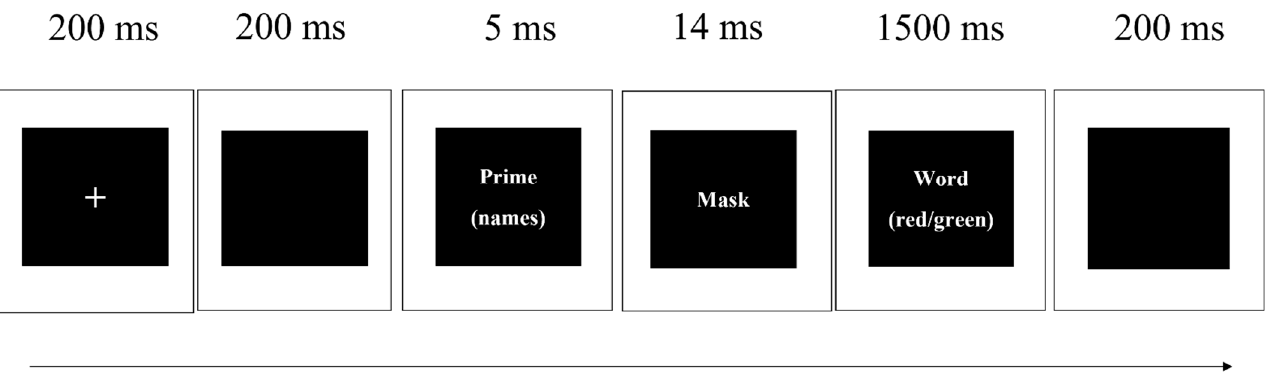
Figure 1. Procedure of